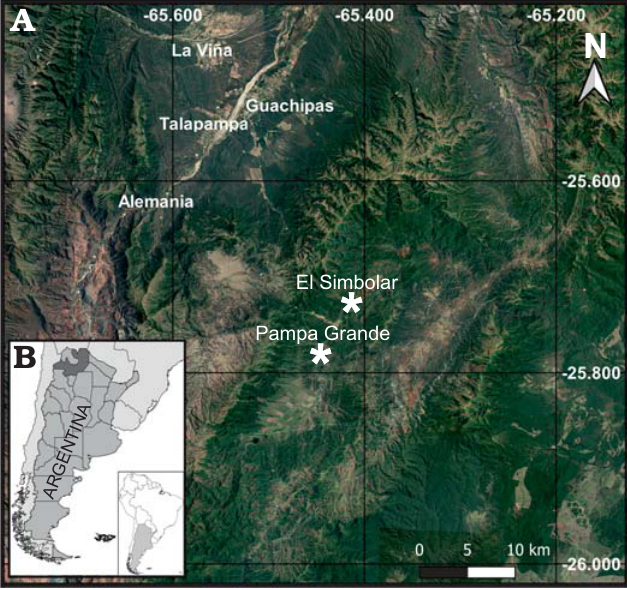
Fig. 1. Satellite images showing location of Guachipas Department, Salta Province, Argentina ( B , dark grey) and of the fossil-bearing locali ties Pampa Grande and El Simbolar ( A ,